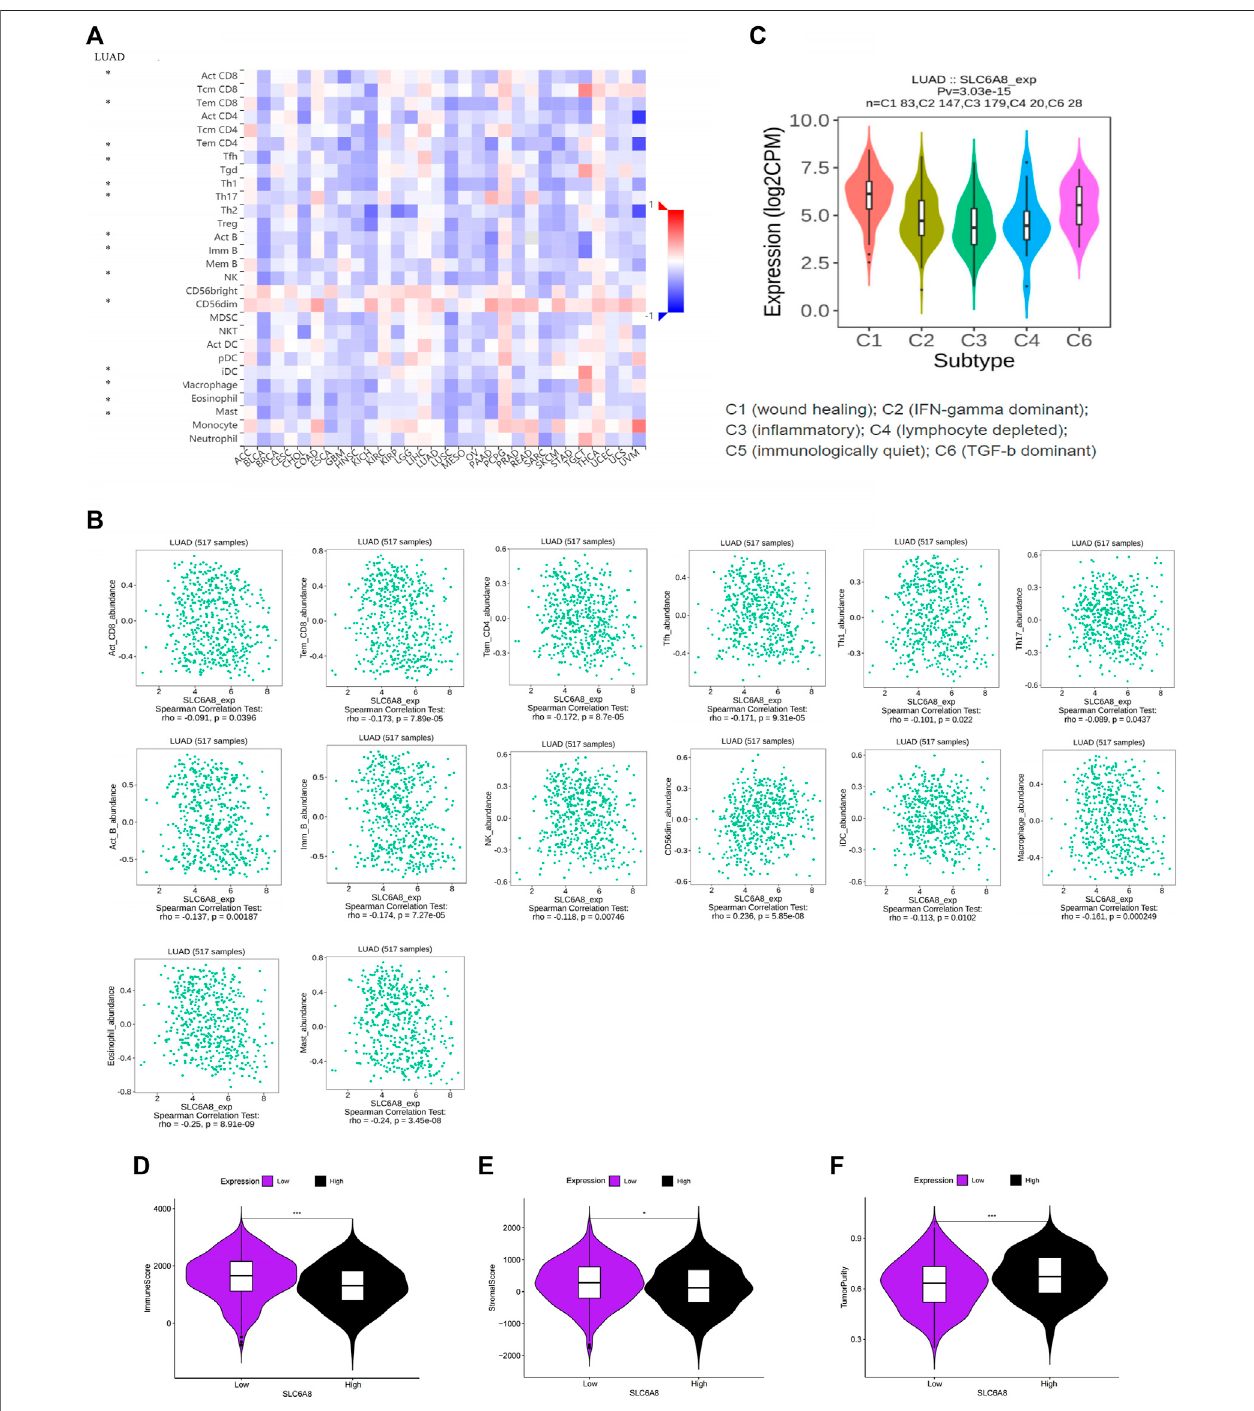
FIGURE 4 | Association between SLC6A8 expression with immune cells in LUAD (A) Correlation analysis of SLC6A8 expression with cells in pan-cancer. (B) Correlation of SLC6A8 expression with immune cells in LUCAD. (C) Association between SLC6A8 expression and immune subtypes in LUAD. Calculated (D) immune cell score. (E) immune stroma score, and (F) tumor purity score in the LUAD immune microenvironment based on the ESTIMATE algorithm *: p -value < 0.05; **: p -value < 0.01; ***: p -value < 0.001.